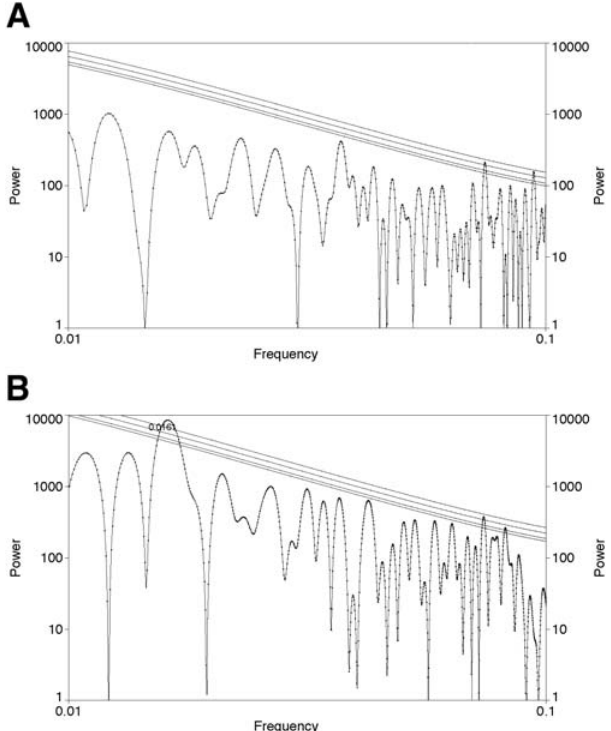
Figure 3. Analysis with LS using AutoSignal; significance levels computed by AutoSignal assuming Gaussian fluctuations and lines denote 0.1, 0.05, 0.01, and 0.001 levels of significance. Frequencies are given per Myr. A. Analysis of detrended diversity of genera that lived more than 45 Myr. There are no significant peaks except at periods below 20 Myr which are thus near or below the Nyquist frequency. B. Analysis of detrended diversity of genera that lived less than 45 Myr. There is a peak at a frequency of approximately 0.0161/Myr, equivalent to 62 6 3 Myr, significant at better than the .001 level (all other significant peaks are at periods below 20